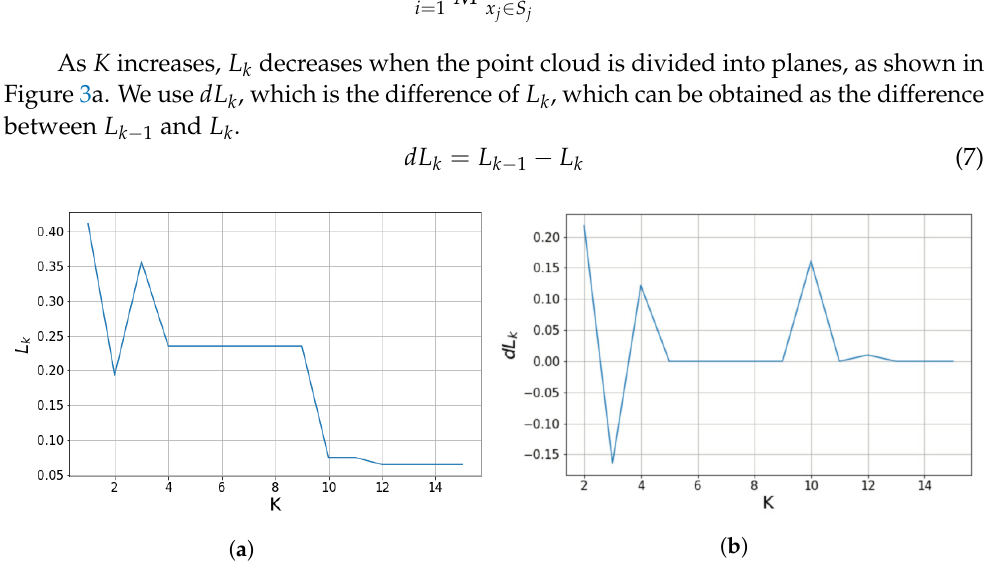
Figure 3. ( a ) Average cosine-distance value of a point cloud calculated by Equation (4) according to K , the number of planes. ( b ) Difference of average cosine-distance calculated by Equation (7). If K is sufficient to cluster point cloud into planes, we can see that the difference of average cosine-distance converges close to zero and no longer changes. By using difference of average cosine-distance, we can obtain the appropriate parameter K